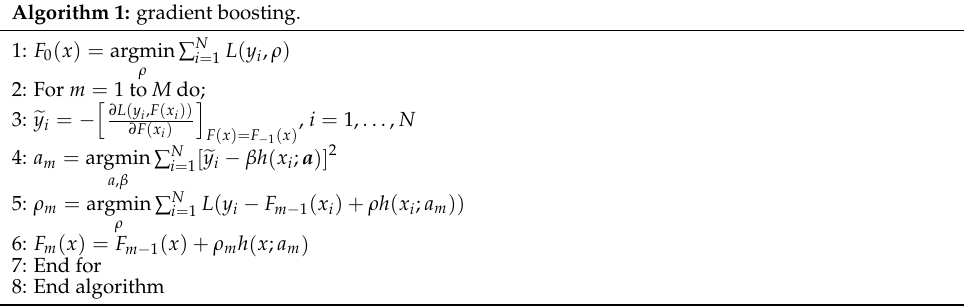
Algorithm 1: gradient